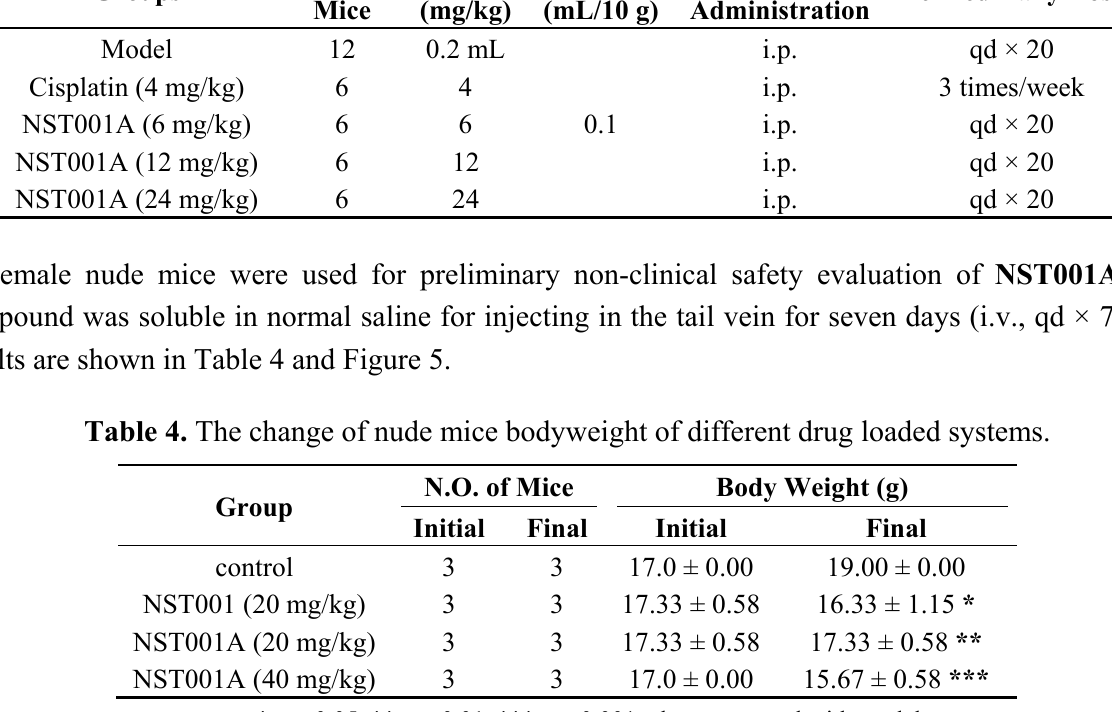
Table 3. The experimental plan of tumor bearing nude mice treated with NST001A. Groups